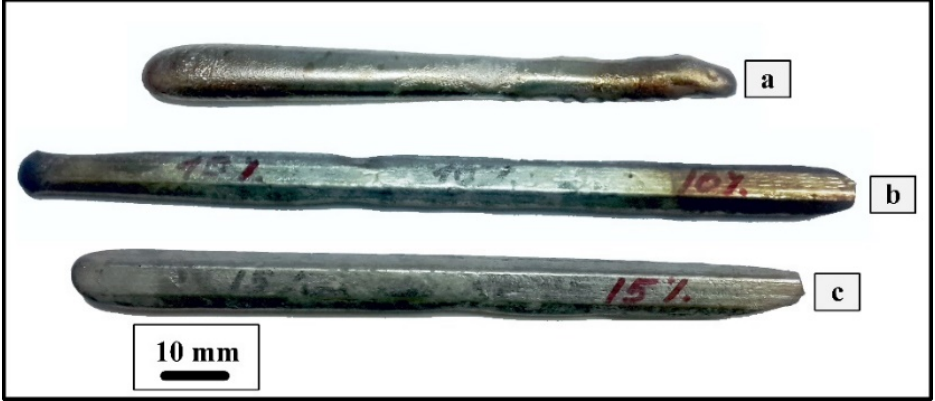
Figure 1. Images of TiNiHf initial ingots obtained by electron beam melting in a copper water-cooled stream-type mold: 1.5 at.% of Hf ( a ), 3.0 at.% of Hf ( b ), and 5.0 at.% of Hf ( c ).